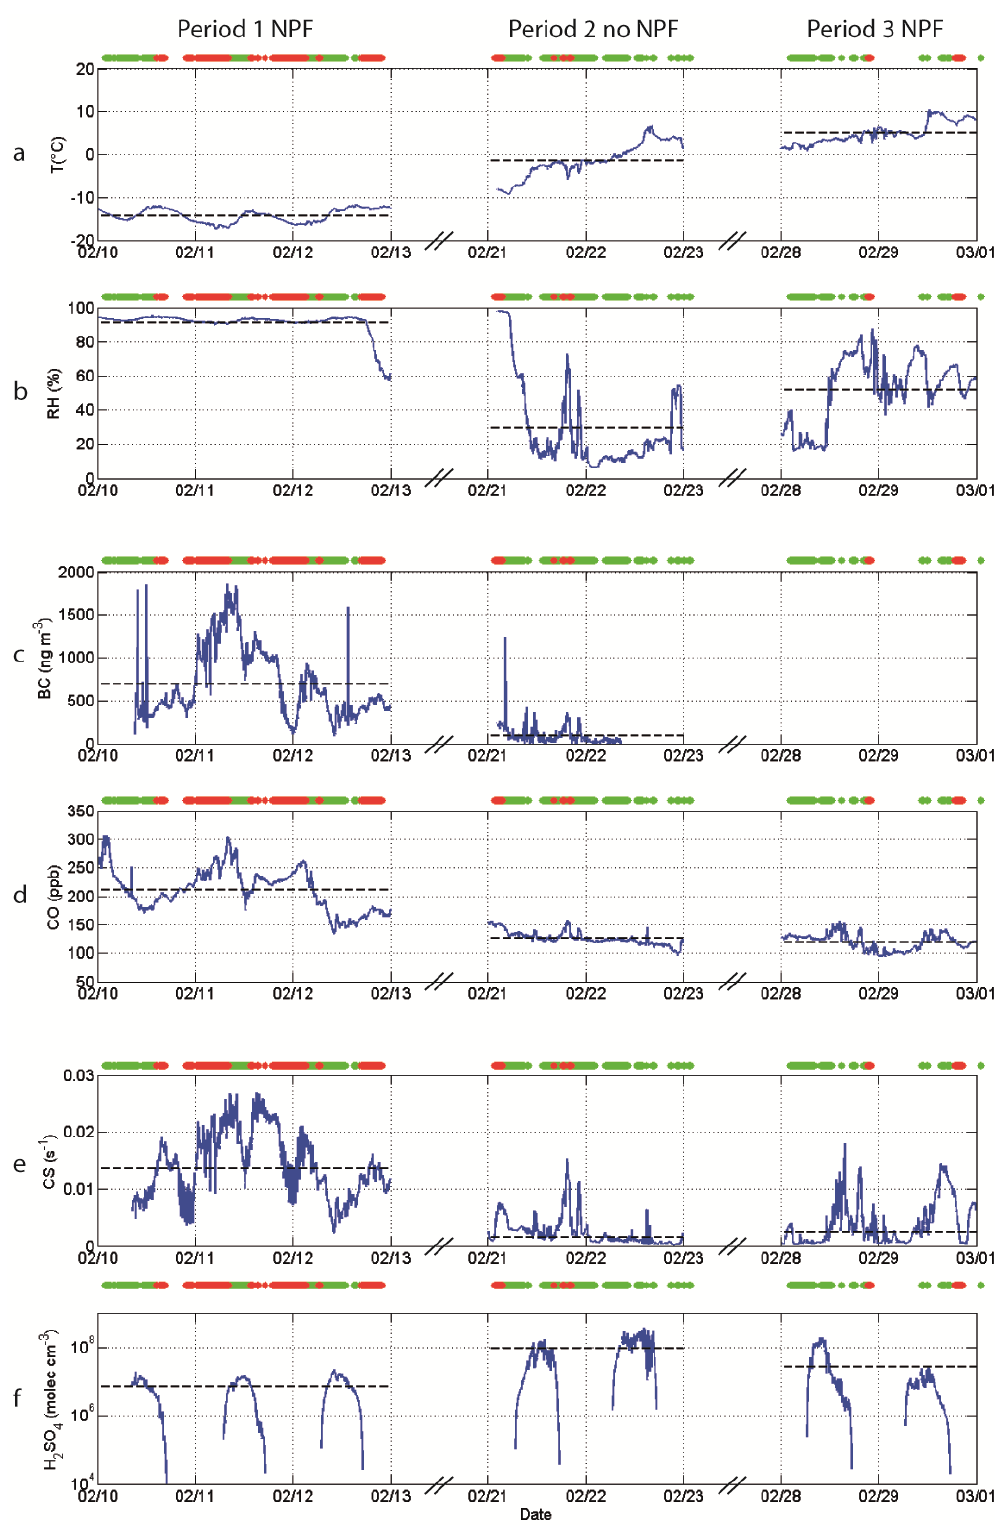
Figure 5. Overview of atmospheric parameters during the studied period. Black dashed lines represent the mean value of each parameter during the three sub-periods. The occurrence of NPF during the sub-periods as well as the location of the station in the BL (red) or in the FT (green) are indicated at the top of the figure. February 2012, Puy de